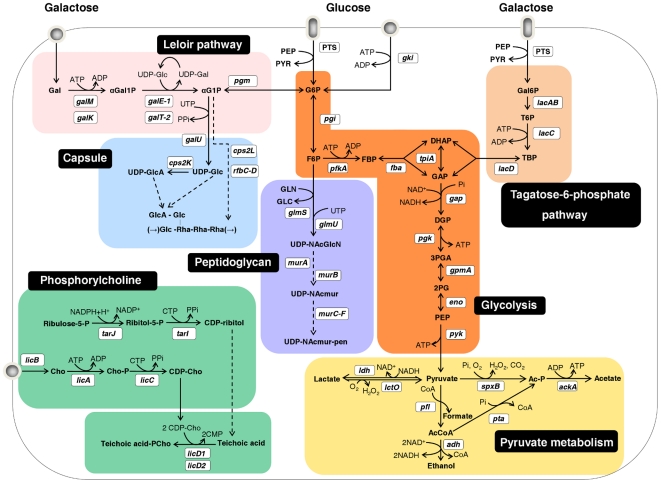
Schematic representation of central metabolic pathways in S. pneumoniae D39.Glc is oxidized to pyruvate via the Embden-Meyerhof-Parnas pathway (Glycolysis, orange box). Homolactic fermentation reduces pyruvate into lactate, whereas mixed-acid fermentation leads to other products, such as formate, acetate and ethanol (Pyruvate metabolism, yellow box). Gal is converted to G6P by the Leloir pathway (light pink box) and to dihydroxyacetone phosphate or glyceraldehyde 3-phosphate by the tagatose 6-phosphate pathway (light orange box). Pathways for capsule, peptidoglycan and phosphorylcholine biosynthesis are shown in light blue, light purple and light green boxes, respectively. Putative and functional characterized genes encoding depicted metabolic steps are shown in white boxes. Proposed pathways were reconstructed based on genome information (http://www.ncbi.nlm.nih.gov/genomes/lproks.cgi), literature and database surveys (KEGG, MetaCyc). Gene annotation downloaded from NCBI: galM, aldose 1-epimerase; galK, galactokinase; galE-1, UDP-glucose 4-epimerase; galT-2, galactose 1-phosphate uridylyltransferase; pgm, phosphoglucomutase/phosphomannomutase family protein; galU, UTP-glucose 1-phosphate uridylyltransferase; cps2L, glucose 1-phosphate thymidylyltransferase; cps2K, UDP-glucose 6-dehydrogenase, putative; rfbC, dTDP-4-dehydrorhamnose 3,5-epimerase, putative; rfbB, dTDP-glucose 4,6-dehydratase; rfbD, dTDP-4-dehydrorhamnose reductase; gki, glucokinase; pgi, glucose 6-phosphate isomerase; pfkA, 6-phosphofructokinase; fba, fructose bisphosphate aldolase; tpiA, triosephosphate isomerase; gap, glyceraldehyde-3-phosphate dehydrogenase; pgk, phosphogltcerate kinase; gpmA, phosphoglyceromutase; eno, phosphopyruvate hydratase; pyk, pyruvate kinase; lacA, galactose 6-phosphate isomerase subunit LacA; lacB, galactose 6-phosphate isomerase subunit LacB; lacC, tagatose 6-phosphate kinase; lacD, tagatose 1,6-diphosphate aldolase; ldh, L-lactate dehydrogenase; lctO, lactate oxidase; spxB, pyruvate oxidase; ackA, acetate kinase; pta, phosphotransacetylase; pfl, pyruvate formate-lyase; adh (spd_1834), bifunctional acetaldehyde-CoA/alcohol dehydrogenase; glmS, D-fructose 6-phosphate amidotransferase; glmU, UDP-N-acetylglucosamine pyrophosphorylase; murA-1 and murA-2, UDP-N-acetylglucosamine 1-carboxyvinyltransferase; murB, UDP-N-acetylenolpyruvoylglucosamine reductase; murC, UDP-N-acetylmuramate-L-alanine ligase; murD, UDP-N-acetylmuramoyl-L-alanyl-D-glutamate synthetase; murE, UDP-N-acetylmuramoylalanyl-D-glutamate-2,6-diaminopimelate ligase; murF, UDP-N-acetylmuramoylalanyl-D-glutamyl-2, 6-diaminopimelate–D-alanyl-D-alanyl ligase; tarJ (spd_1126), alcohol dehydrogenase, zinc-containing or TarJ; tarI (spd_1127), 2-C-methyl-D-erythritol 4-phosphate cytidylyltransferase or TarI; licB, protein LicB; pck, choline kinase or LicA; licC, CTP:phosphocholine cytidylyltransferase; LicD1, phosphotransferase LicD1; LicD2, phosphotransferase LicD2.